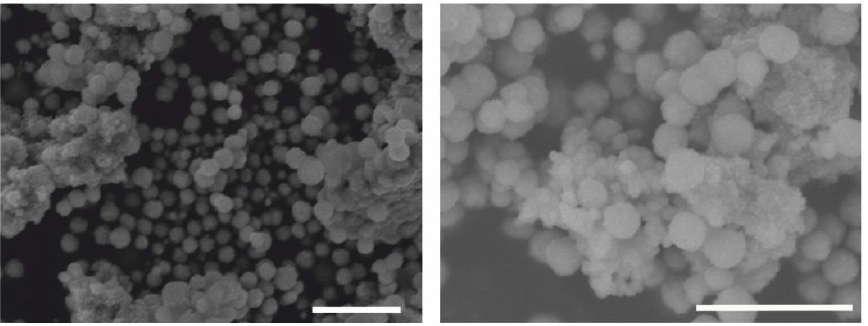
Figure 4. Representative SEM images of Fe 3 O 4 @SiO 2 -SH nanoparticles. The scale bars are 1 µm in both SEM micrographs.